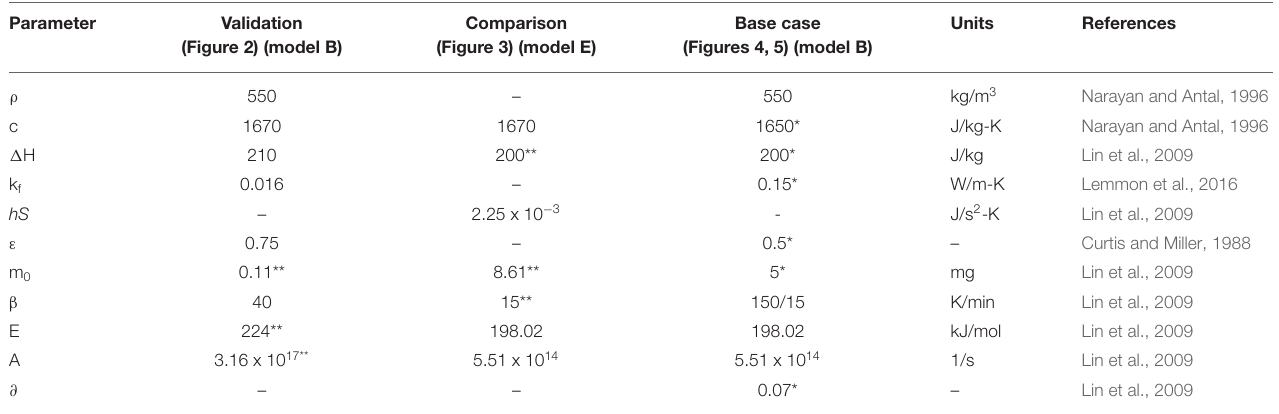
TABLE 1 | Parameters for the validation and sensitivity study of the models.